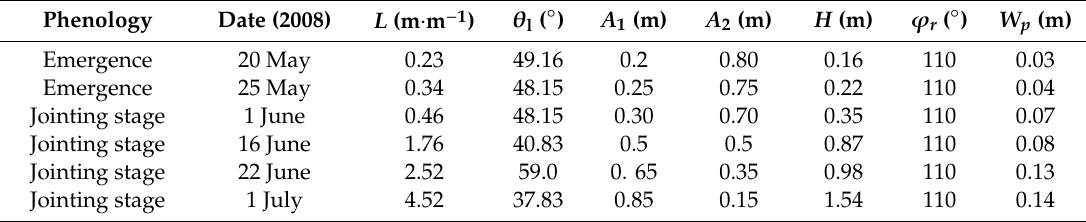
Table 2. Structural parameters of corn in the growing season.